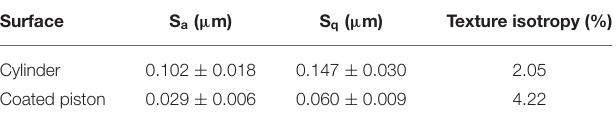
TABLE 5 | Surface topographical parameters before tribological